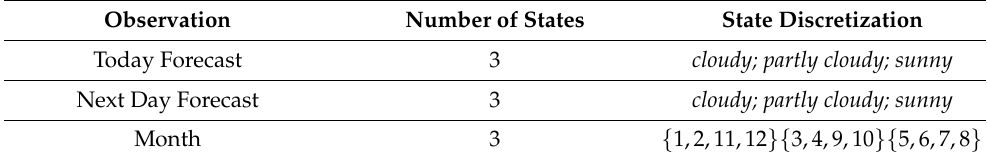
Table 1. Discretized states used in the RL algorithm.